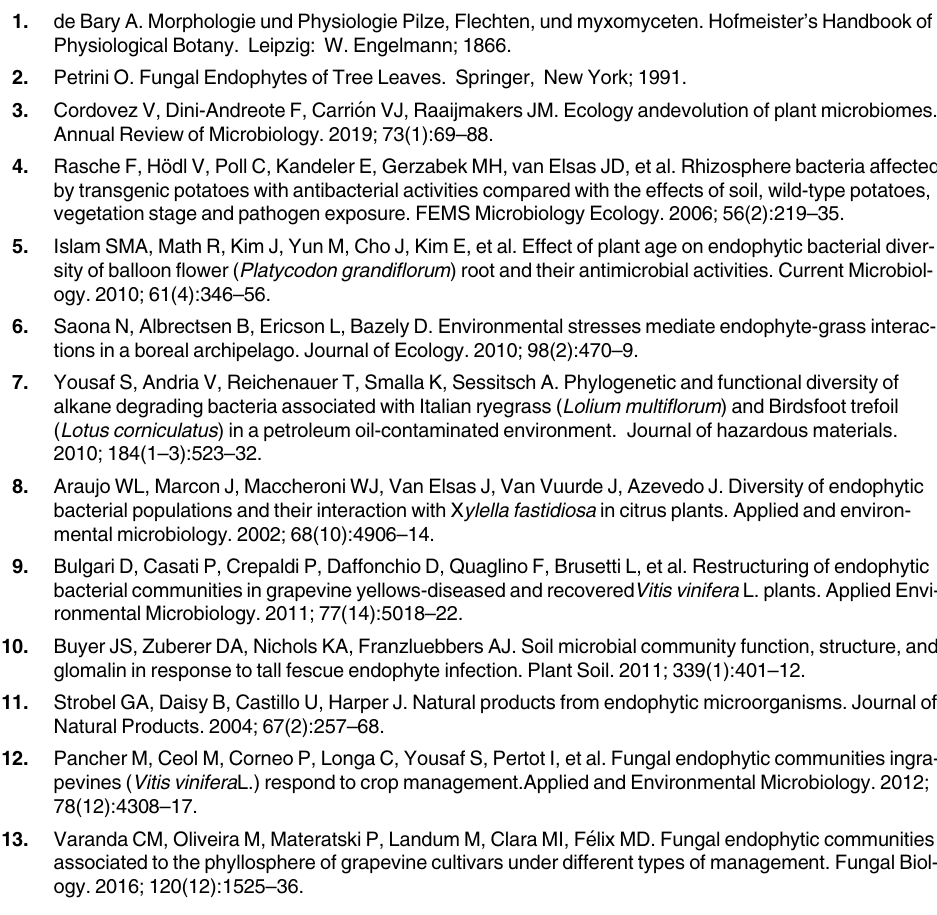
S7 Fig. The preliminary experiment to evaluate the presence of catechin in CS leaves treated with strain